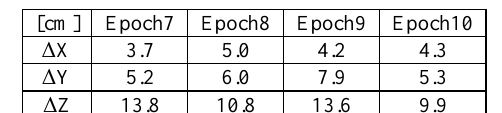
Table 5. The RMSE for RIBC for 18 even distributed images (Epochs 7-10).